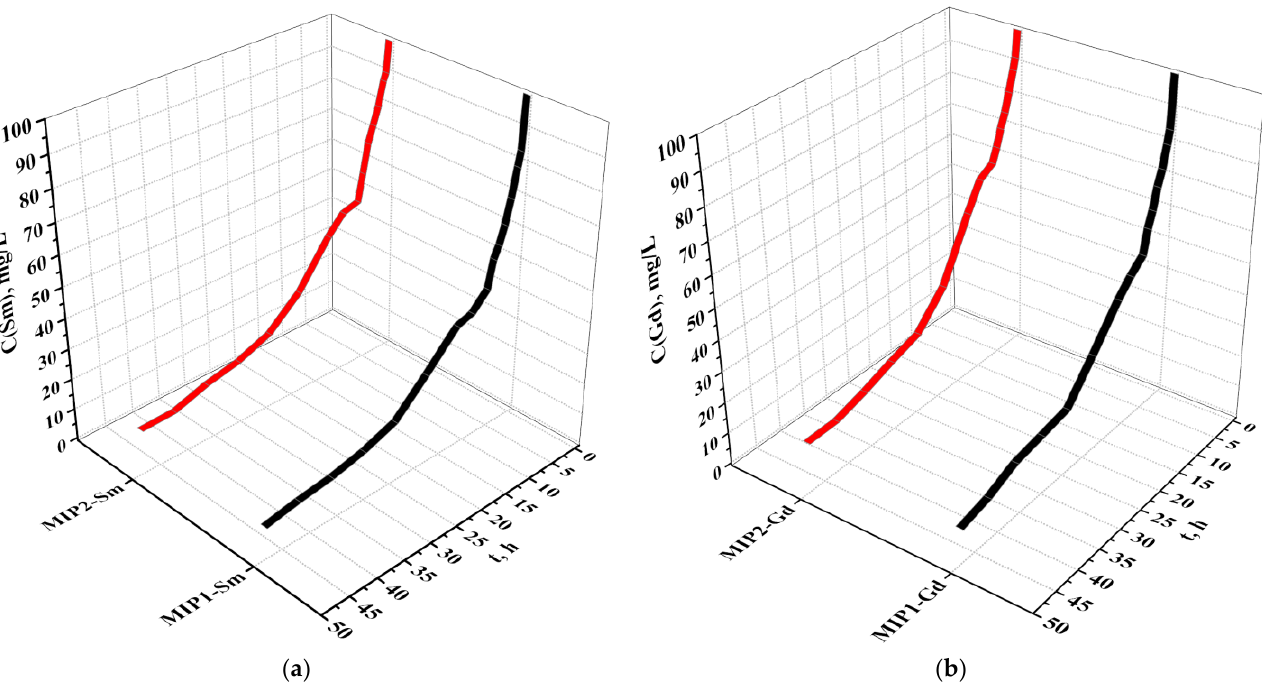
Figure 4. Decrease of samarium ( a ) and gadolinium ( b ) concentrations during sorption via molecu- larly imprinted polymers.